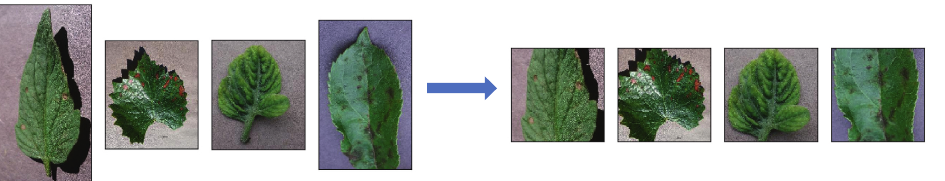
Figure 2: Image cutting.